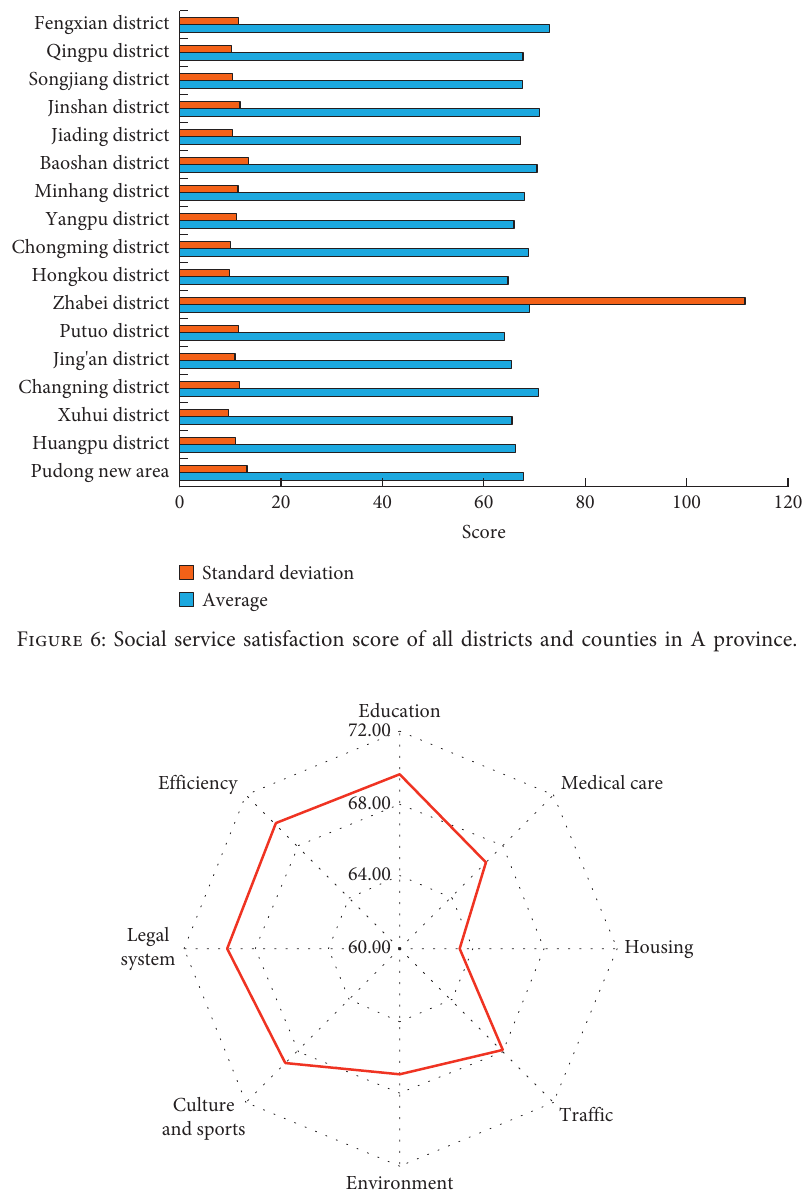
Figure 7: Radar chart of social service satisfaction